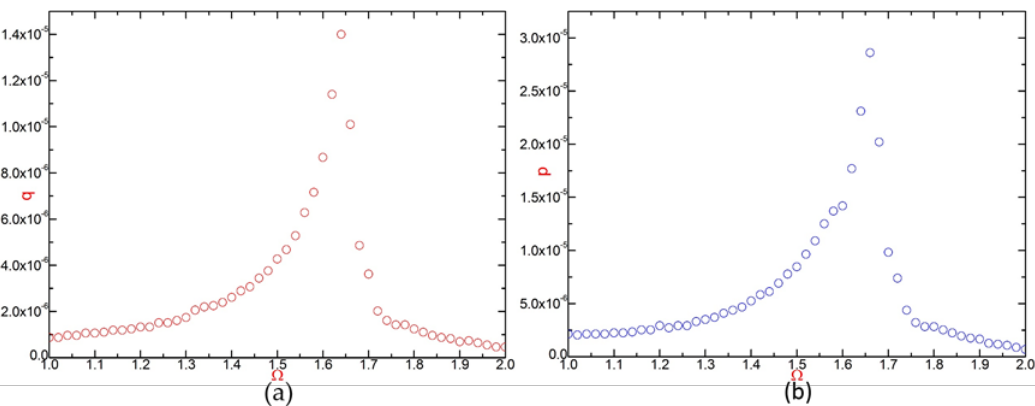
Figure 6. 1st order generalized coodinate of the frequency response curve (a) in transvese direction (b) in rotation direction.